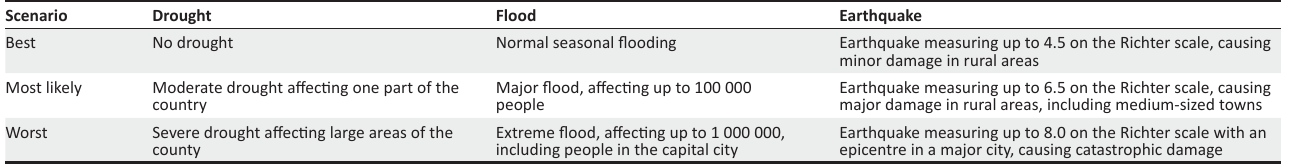
TABLE 1: Best-case, middle-case and worst-case scenarios for flood, drought and earthquakes.